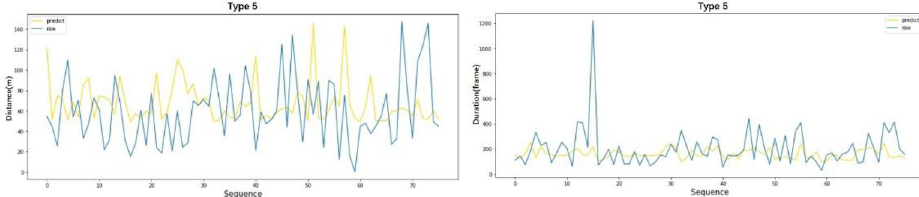
Fig 15. Prediction results of the weaving model for type